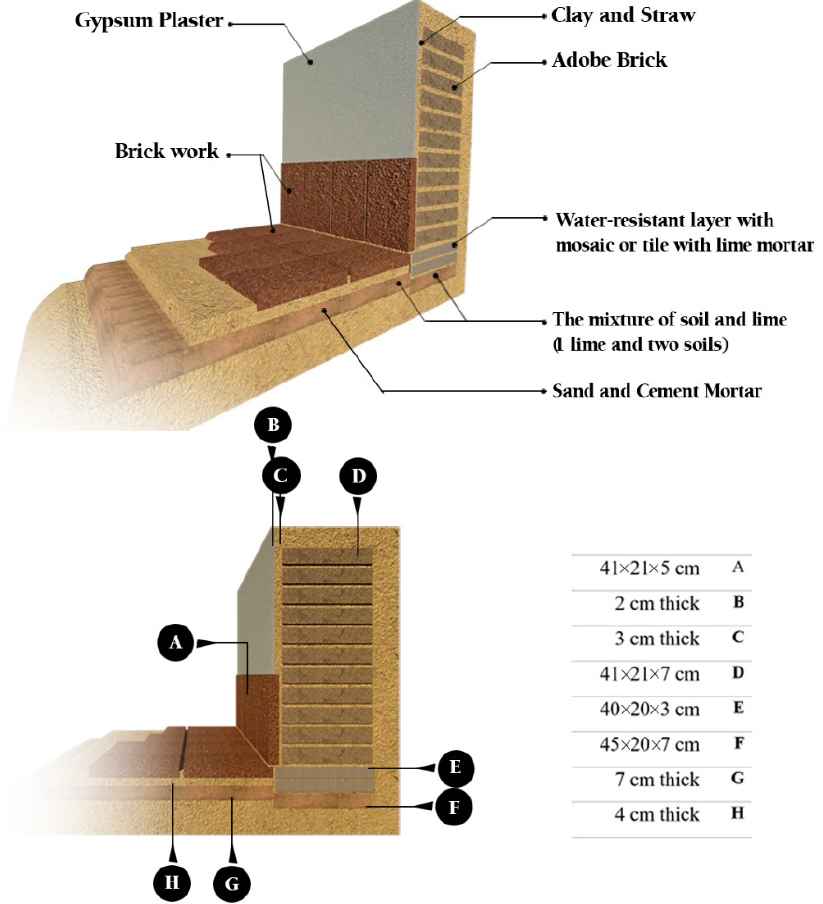
Figure 9. Example of architectural detail for conservation walls meeting the ground level.